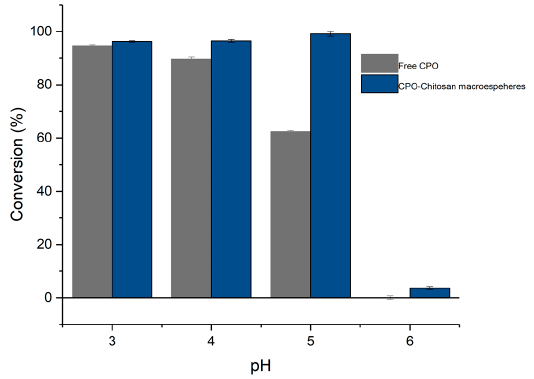
Figure 6. Profile of activity versus pH for free CPO and the CPO–chitosan macrospheres during the oxidation of ketorolac. oxidation of